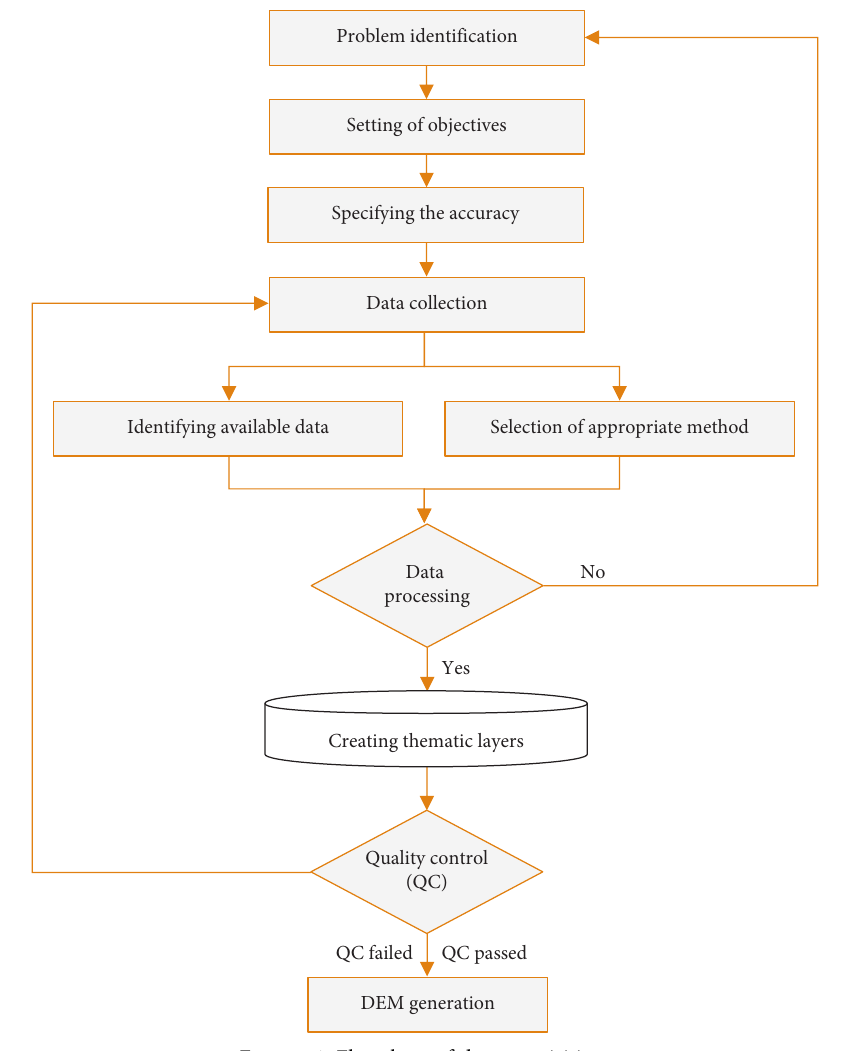
Figure 4: Flowchart of data acquisition.